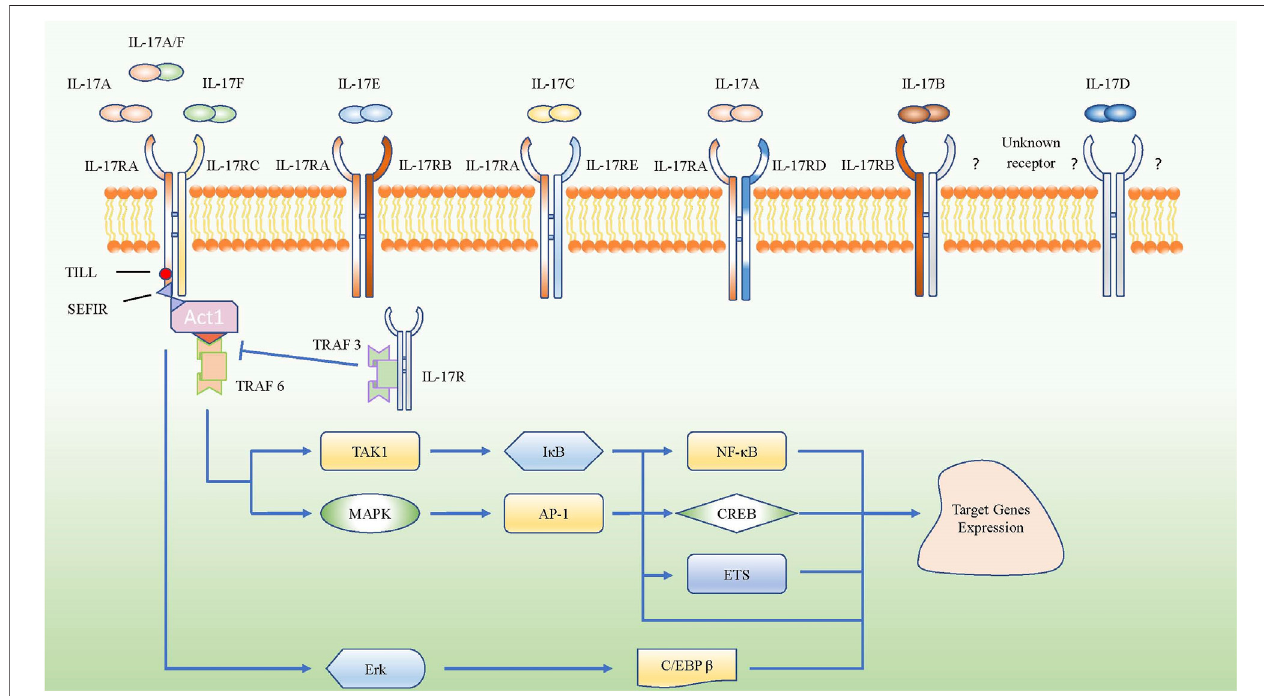
FIGURE 1 | Schematic represent IL-17 family subgroup and their corresponding receptors from IL-17 receptor family. IL-17A, IL-17A/F and IL-17F share the IL- 17RA/RC heterodimeric receptor. The intracellular domains of all IL-17R encode conserved SEFIR domains which interact with a corresponding SEFIR motif on the adaptor Act1, then they combine with TRAF6 to activate the pathway of NF- κ B and MAPK. However, TRAF3 could inhibit SEFIR- Act1- TRAF6 pathway by competitive binding the IL-17RA directly. Only IL-17RA own the CBAD and TILL, which can promote the target gene expressions via C/EBP β pathway.